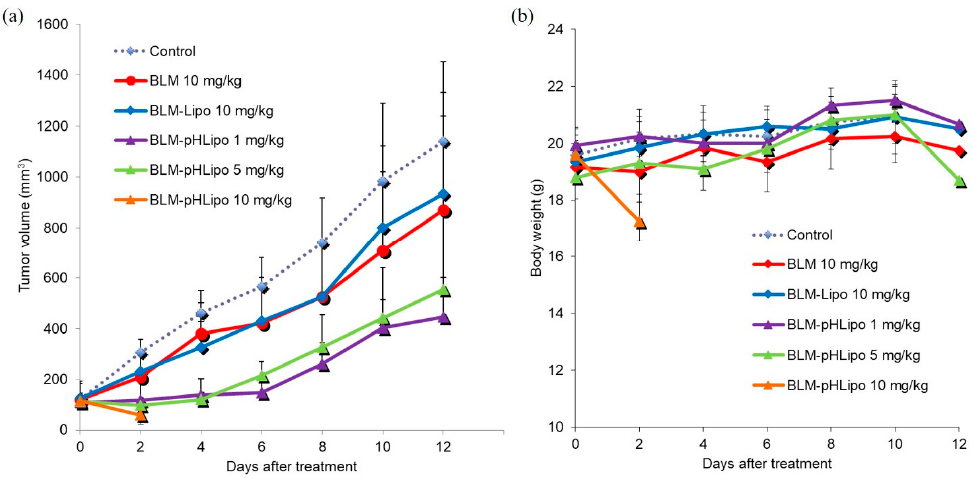
Figure 6. In vivo antitumor effect of BLM-loaded liposomes. Free BLM, BLM-Lipo, or BLM-pHLipo was administered intravenously to Colon-26 tumor-bearing BALB/c mice. Changes in ( a ) tumor volume (mm 3 ) and ( b ) body weight were monitored ( n = 6). Control vs. BLM-pHLipo (1 mg/kg): p = 0.001; Control vs. BLM-pHLipo (5 mg/kg): p = 0.023; BLM-Lipo (10 mg/kg) vs. BLM-pHLipo (1 mg/kg): p = 0.013; Friedman test.